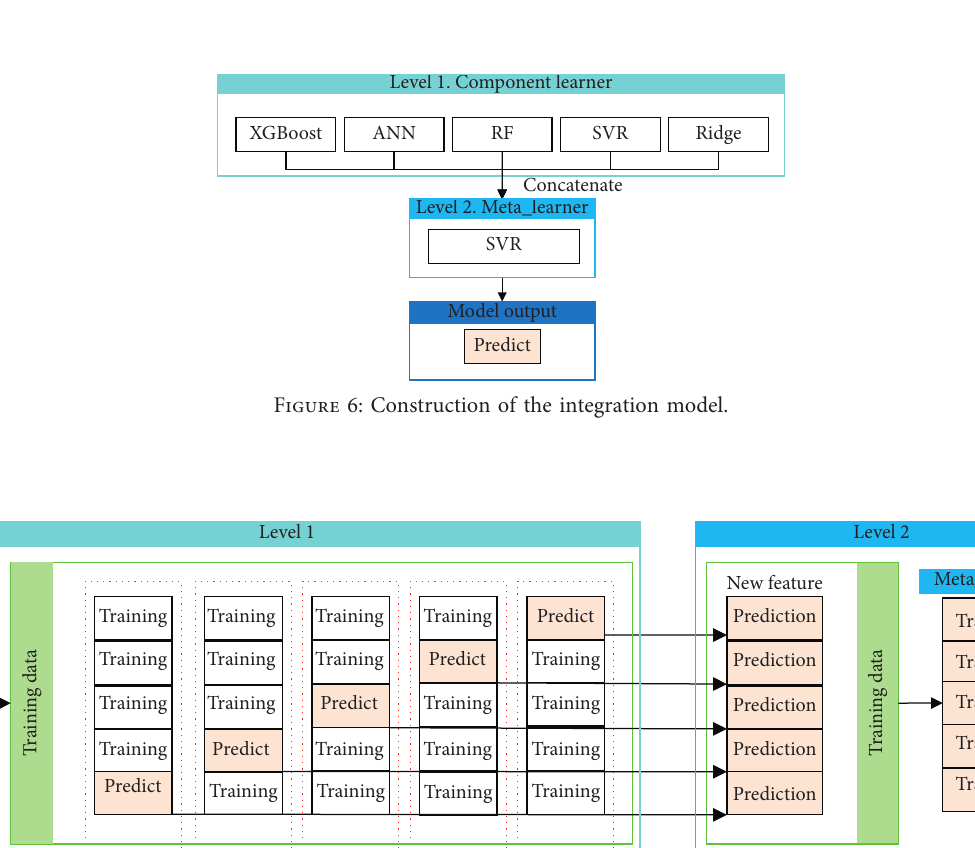
Figure 5: Correlation analysis.